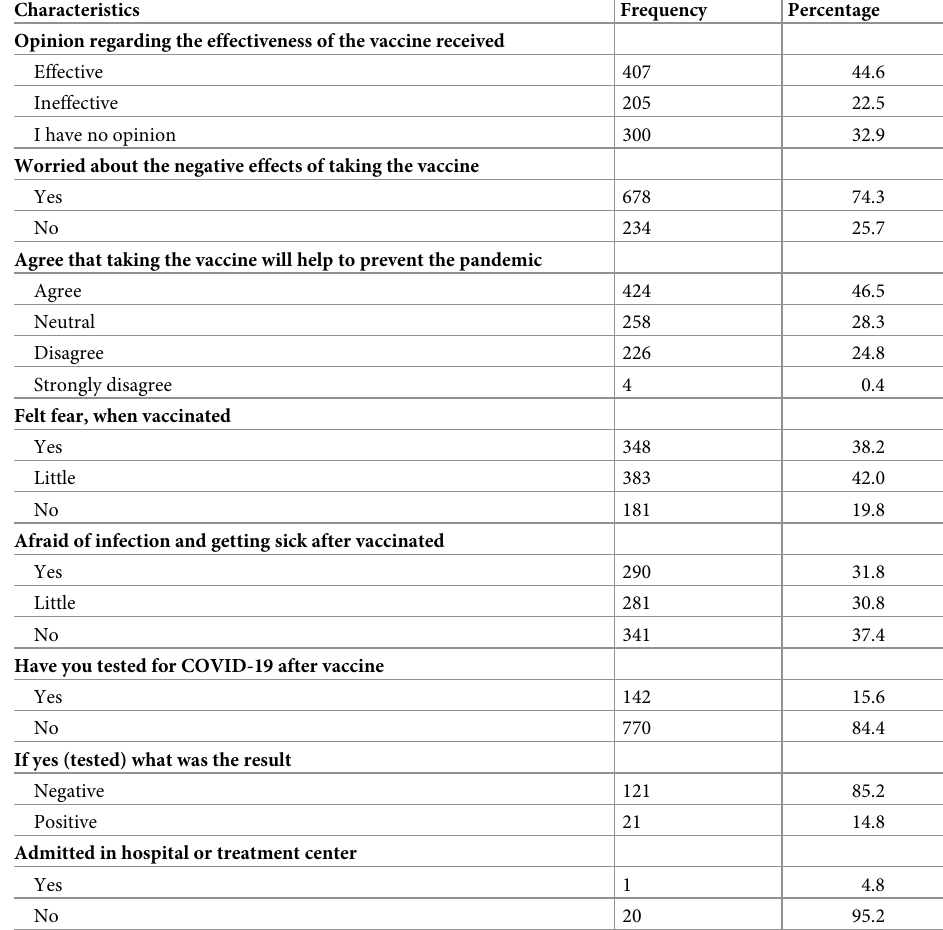
Table 4. Perceptions related to COVID-19 vaccine and Re-infection among participants for the study of COVID- 19 Vaccine complication evaluations in central Oromia region, Ethiopia, 2021. Characteristics